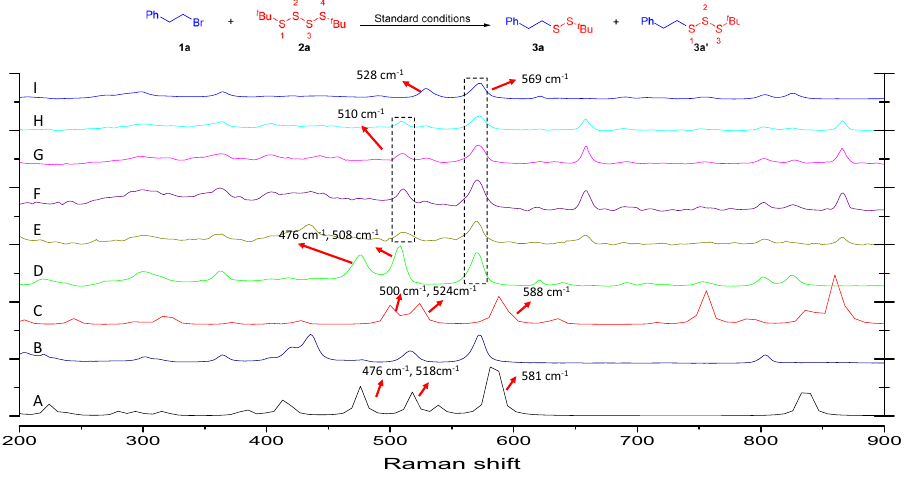
Fig. 7 Raman study (I). Raman caculation spectra of (A) 2a calculated data. (B) 2a . (C) 3a ′ calculated data. (D) 3a ′ . (E) 1a with 2a under optimized reaction conditions, t = 1 h, (F) 1a with 2a under optimized reaction conditions, t = 4 h, (G) 1a with 2a under optimized reaction conditions, t = 8 h, (H) 1b with 2a under optimized reaction conditions, t = 1 h. (I) 3a